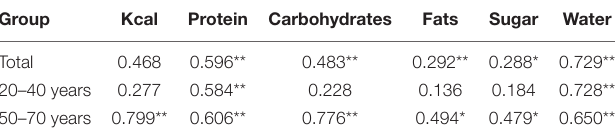
TABLE 2 | Correlations between the DAT and 7 d-FR, by group.